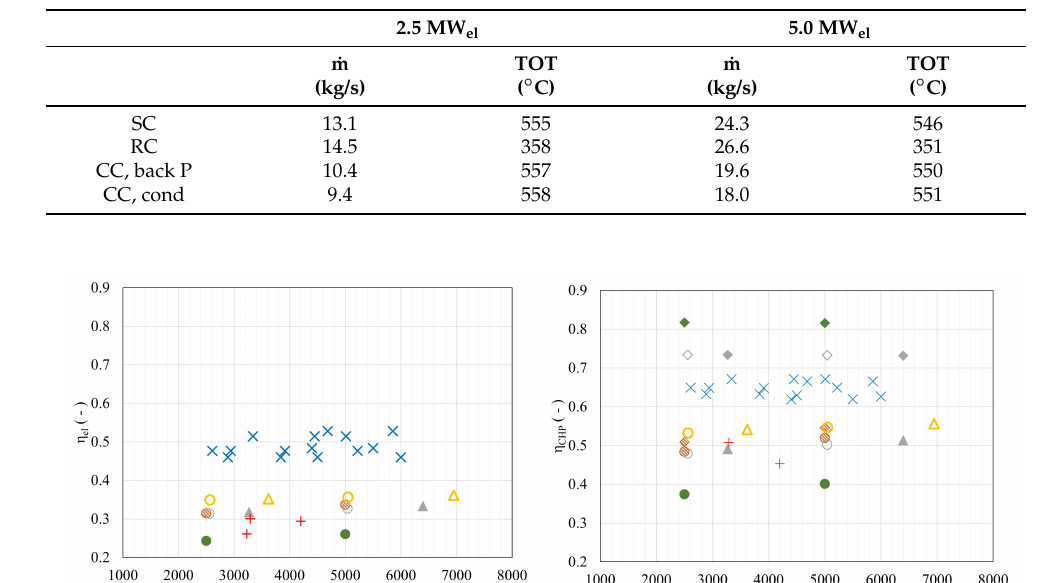
Table 6. Exhaust mass flow rates and temperatures in the calculated Mini GT Cycles; CC values refer to type (A); CC type (B) has same results as SC.